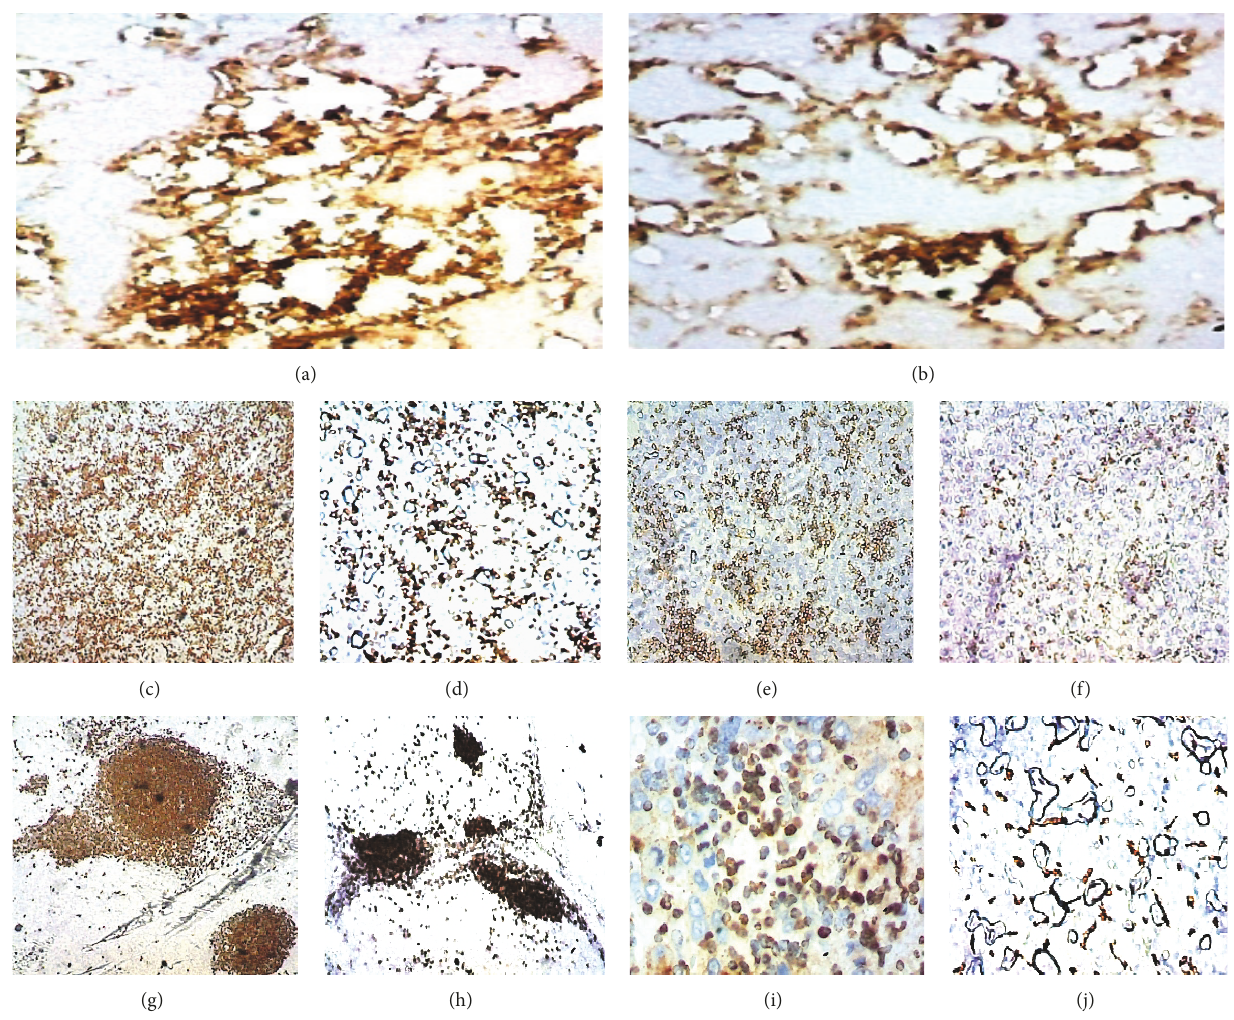
Figure 7: (a-b) CD10;( 200x ); (c) CD3; (d) CD4; (e) CD5; (f) CD8; (g-h) CD20; (i) CD138; (j) CD34 ( 100x